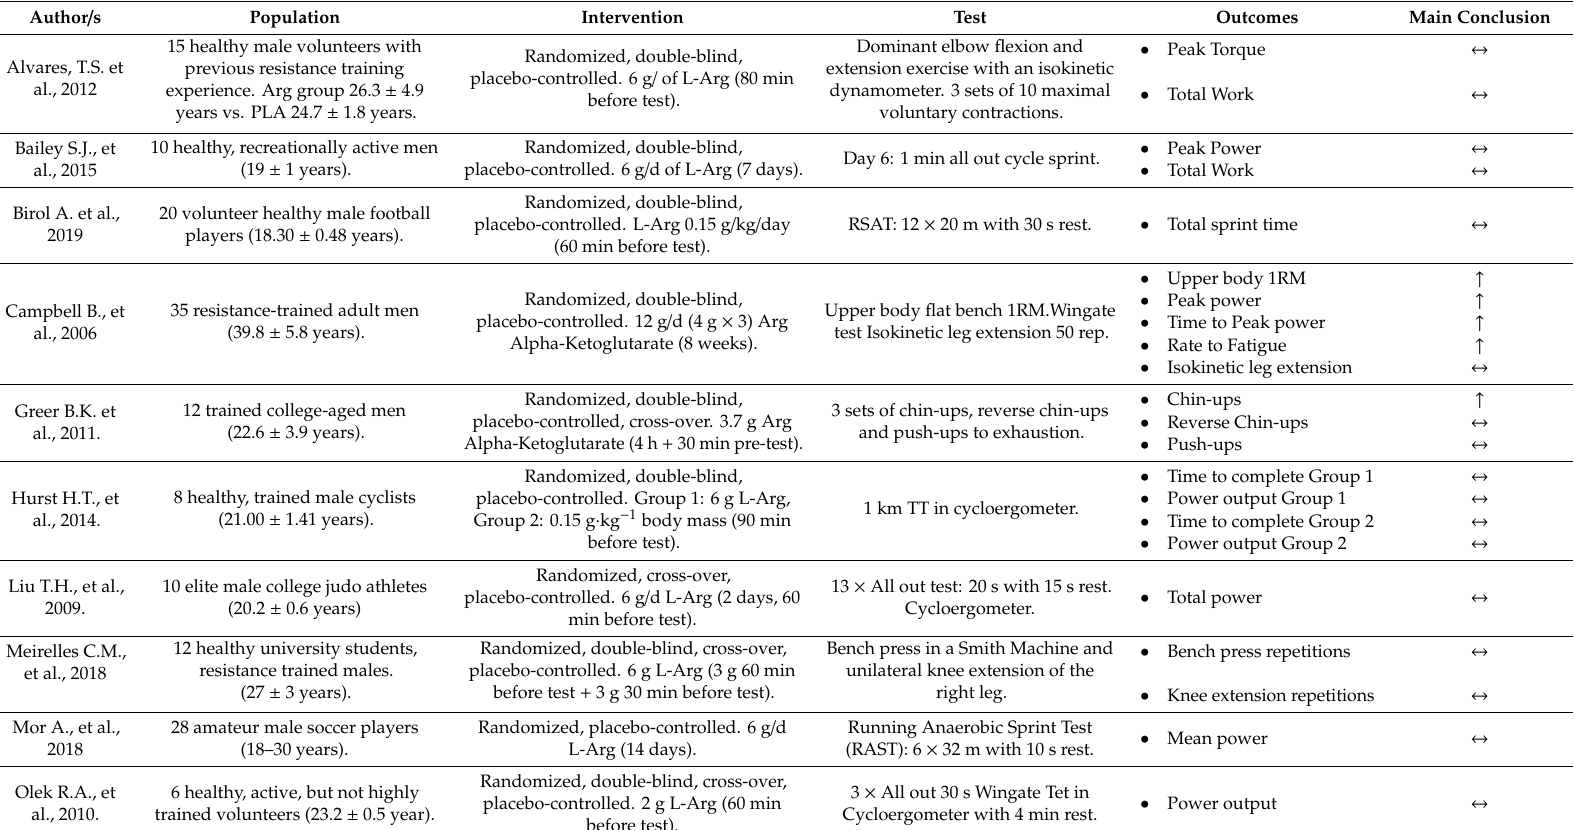
Table 2. Summary of the studies included in the systematic review that investigated the e ff ect of L-Arginine on > VO 2 max Performance (test lasting less than 5 min). Author /